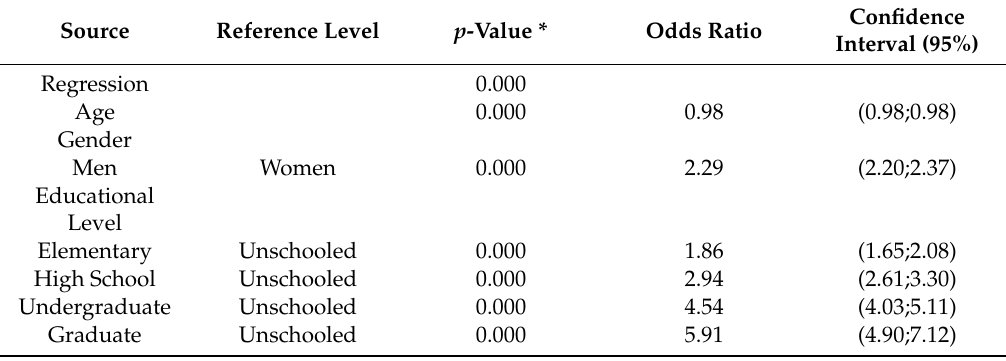
Table 2. Main results of the binary logistical regression—choice of practicing